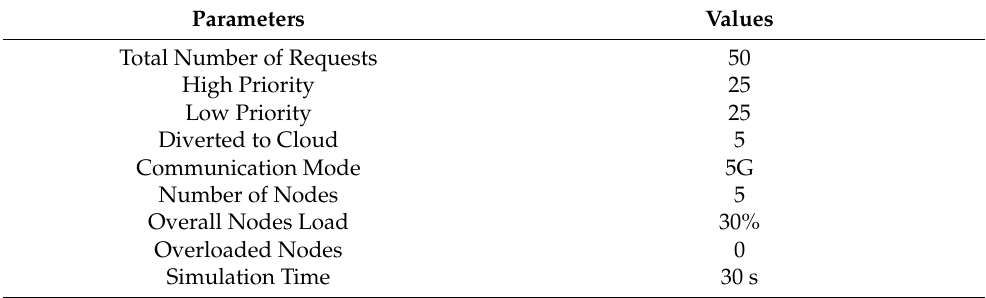
Table 3. Fog scenario